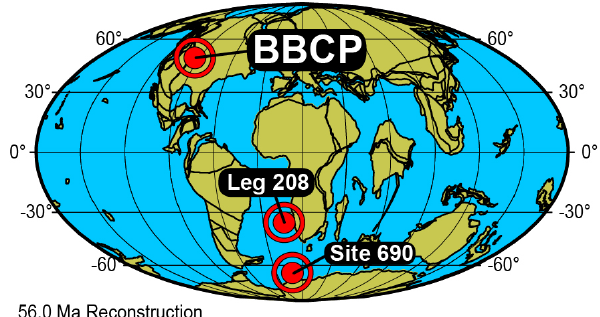
Figure 1. Location map for BBCP (Bighorn Basin Coring Project, Wyoming, USA), ODP Leg 208 (Sites 1260 and 1263), and ODP Leg 113 (Site 690) on a 56 Ma paleogeographic reconstruction in Mollweide projection (from http://www.odsn.de; Hay et al.,